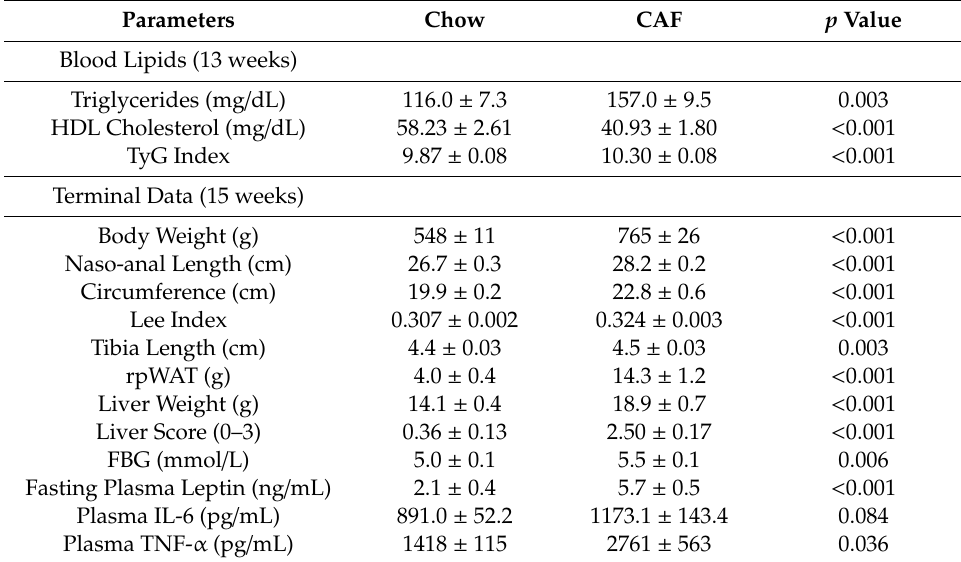
Figure 1. Effect of cafeteria (CAF) diet on energy consumption and body composition in rats. ( A ) Weekly energy intake (kJ/rat/24 h; two-way repeated measures ANOVA, F (1, 4) = 281.7, group ( p < 0.001), time ( p < 0.001) and interaction ( p = 0.059), ( B ) average daily energy consumption in chow control and CAF rats shown as (kJ/rat/24 h; average of 27 measures) (unpaired t-test; p < 0.001), ( C ) breakdown of energy consumed from each macronutrient (kJ/rat/24 h; average of 27 measures; carbohydrate, protein and fat; all p < 0.001, Mann–Whitney test), ( D ) weekly body weights analyzed by two-way repeated measures ANOVA (group × time) showing main effect of group (F (1, 26) = 45.96, p < 0.001), time (F (15, 390) = 770.87, p < 0.001) and time × group interaction (F (15, 390) = 51.38, p < 0.001), ( E ) fat mass (grams) and ( F ) absolute lean mass (grams) in chow and CAF rats measured at 13 weeks of diet. The open circle or bar indicates chow group while the filled circle or bar indicates CAF group (*** p < 0.001 versus chow). n = 14/group in panels ( A – D ) and n = 15/group in panels ( E , F ). Table 1. Blood lipids (13 weeks) and endpoint measures (15 weeks).